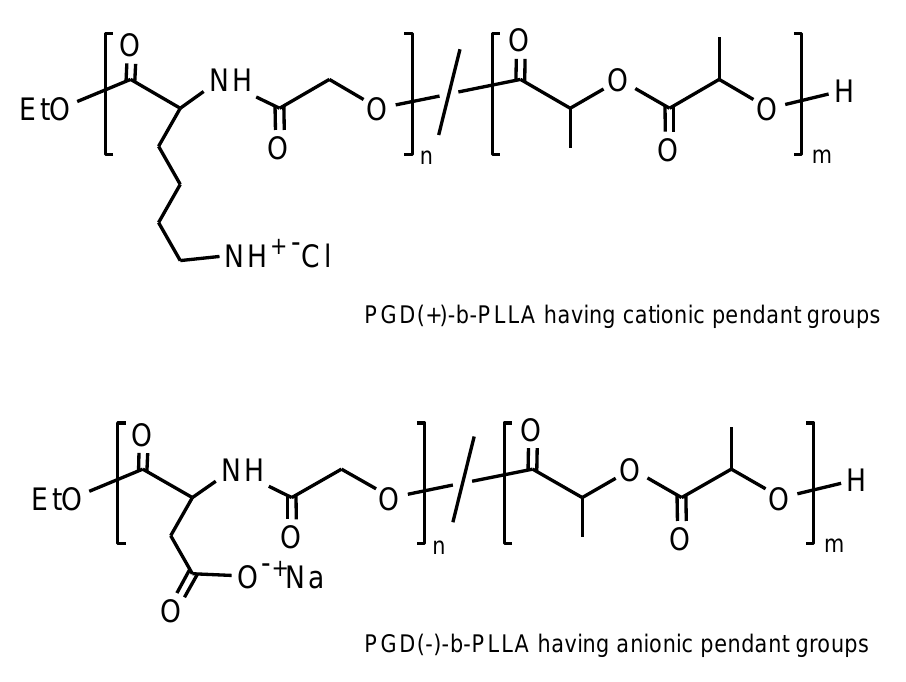
Figure 22. Amphiphilic block copolymers consisting of polylactide and polydepsipeptide with interest as drug delivery